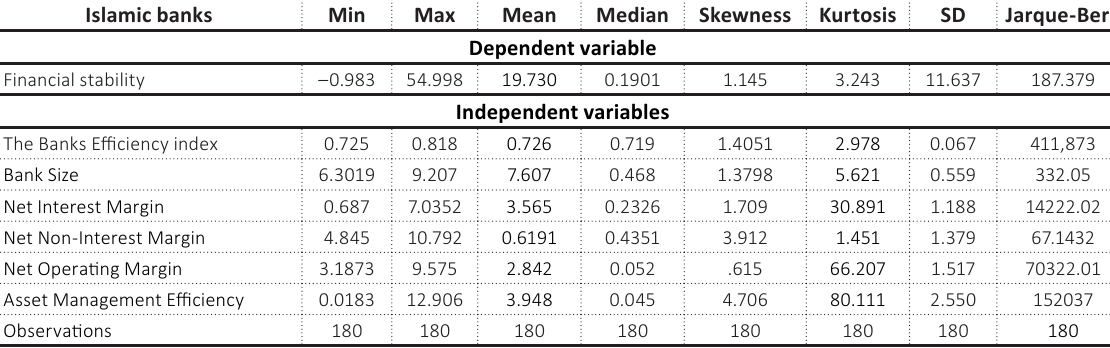
Table 3. Descriptive statistics (Model